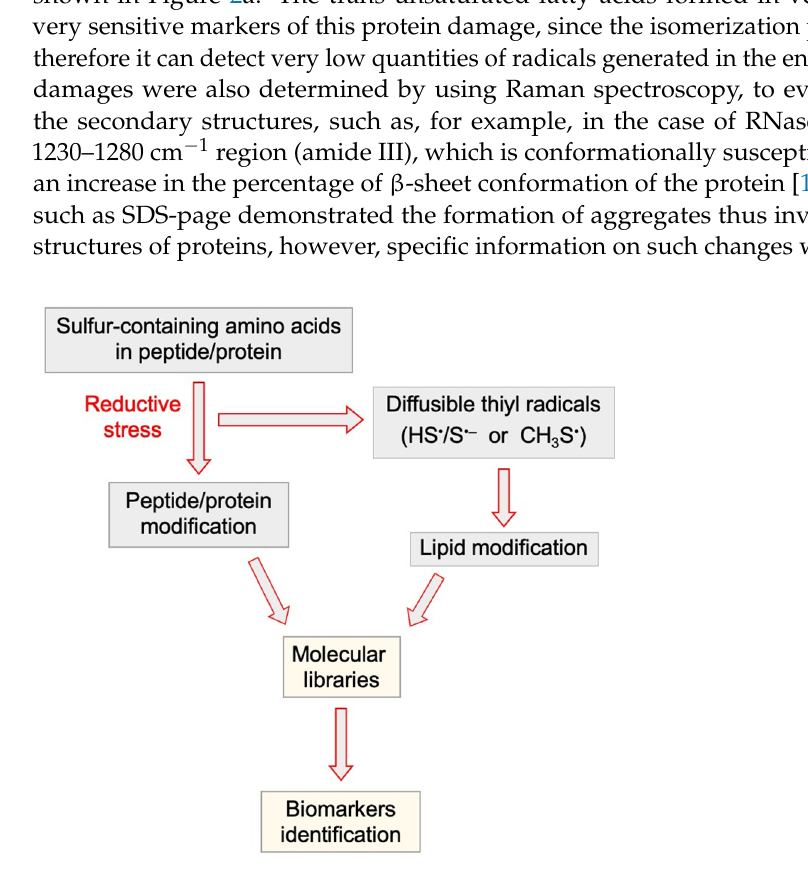
Figure 3. Concept of reductive stress and steps of the tandem protein–lipid damage leading to molecular libraries for biomarker identification.